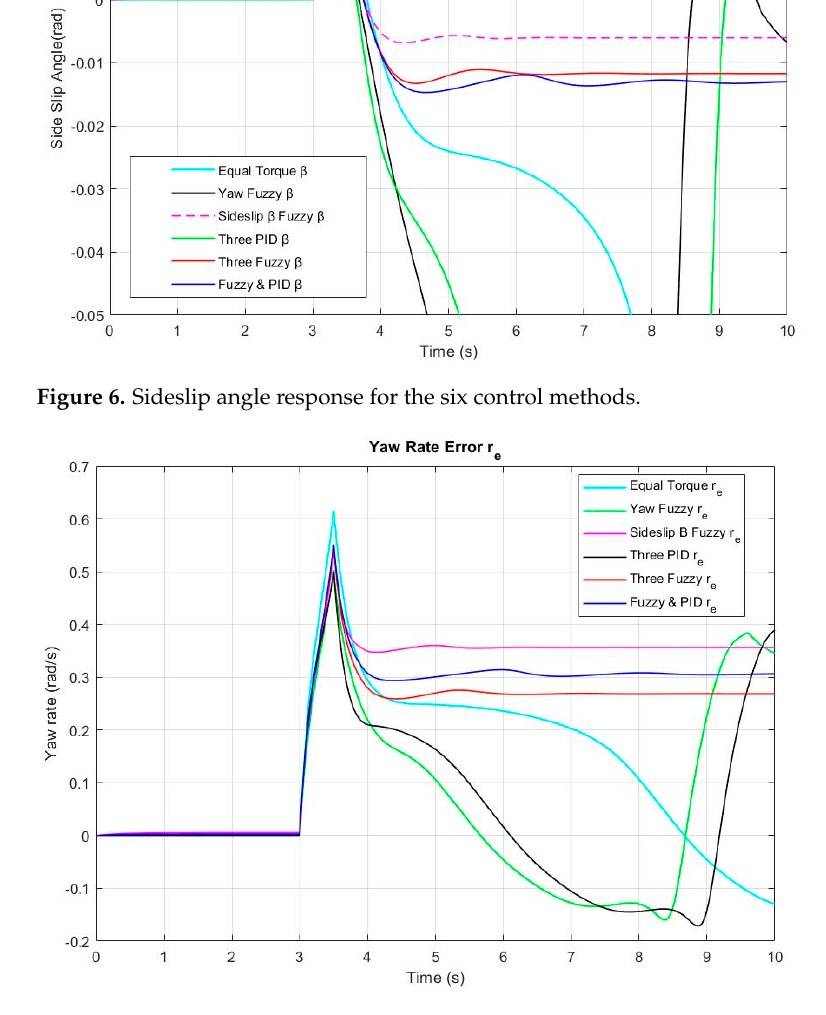
Figure 7. Yaw rate error response for the six control methods.